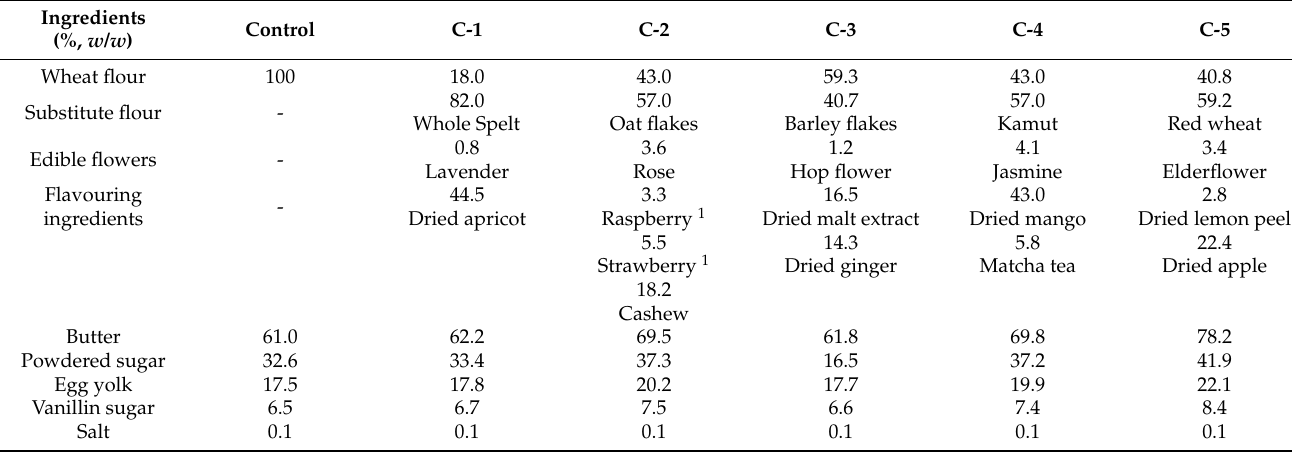
Table 1. Recipe of the cookies supplemented with uncommon cereal flours, edible flower and dried fruit flours. Ingredients (%, w / w